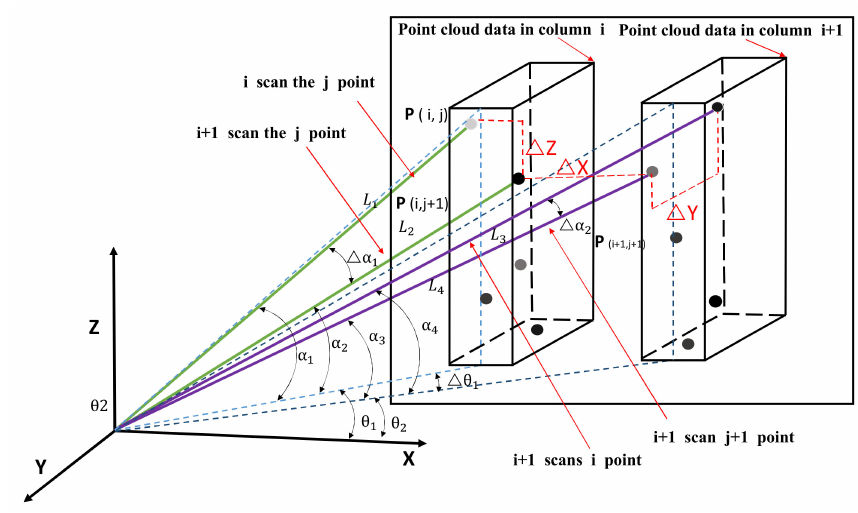
Figure 12. Schematic diagram of 2D single-line LiDAR scanning